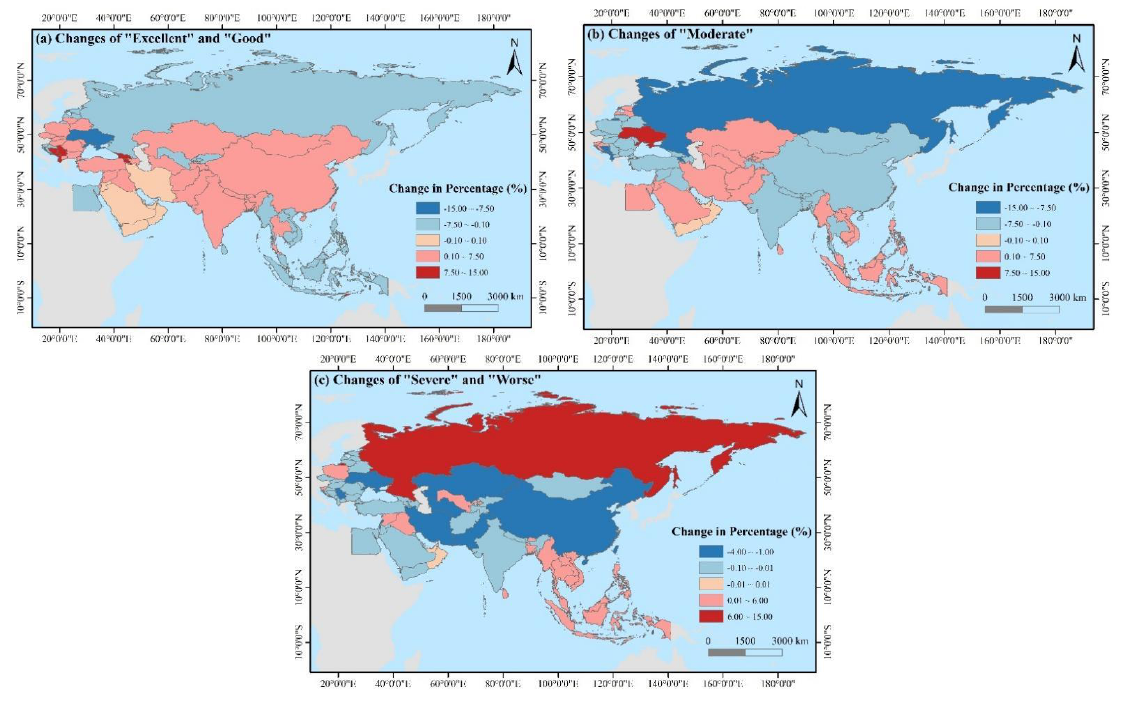
Figure 4. ( a ) Changes of “good” and above ecological quality in 65 countries in the Pan-Third Pole region from 2000 to 2020; ( b ) Changes of “moderate” ecological quality in 65 countries in the Pan-Third Pole region from 2000 to 2020; ( c ) Changes of “severe” and “worse” ecological quality in 65 countries in the Pan-Third Pole region from 2000 to 2020.